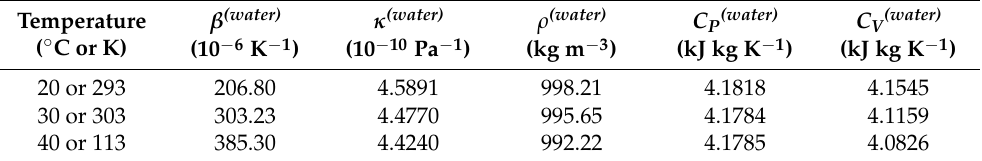
Table 1. Dependence of thermodynamic parameters on thermodynamic equilibrium temperature ( T ) for